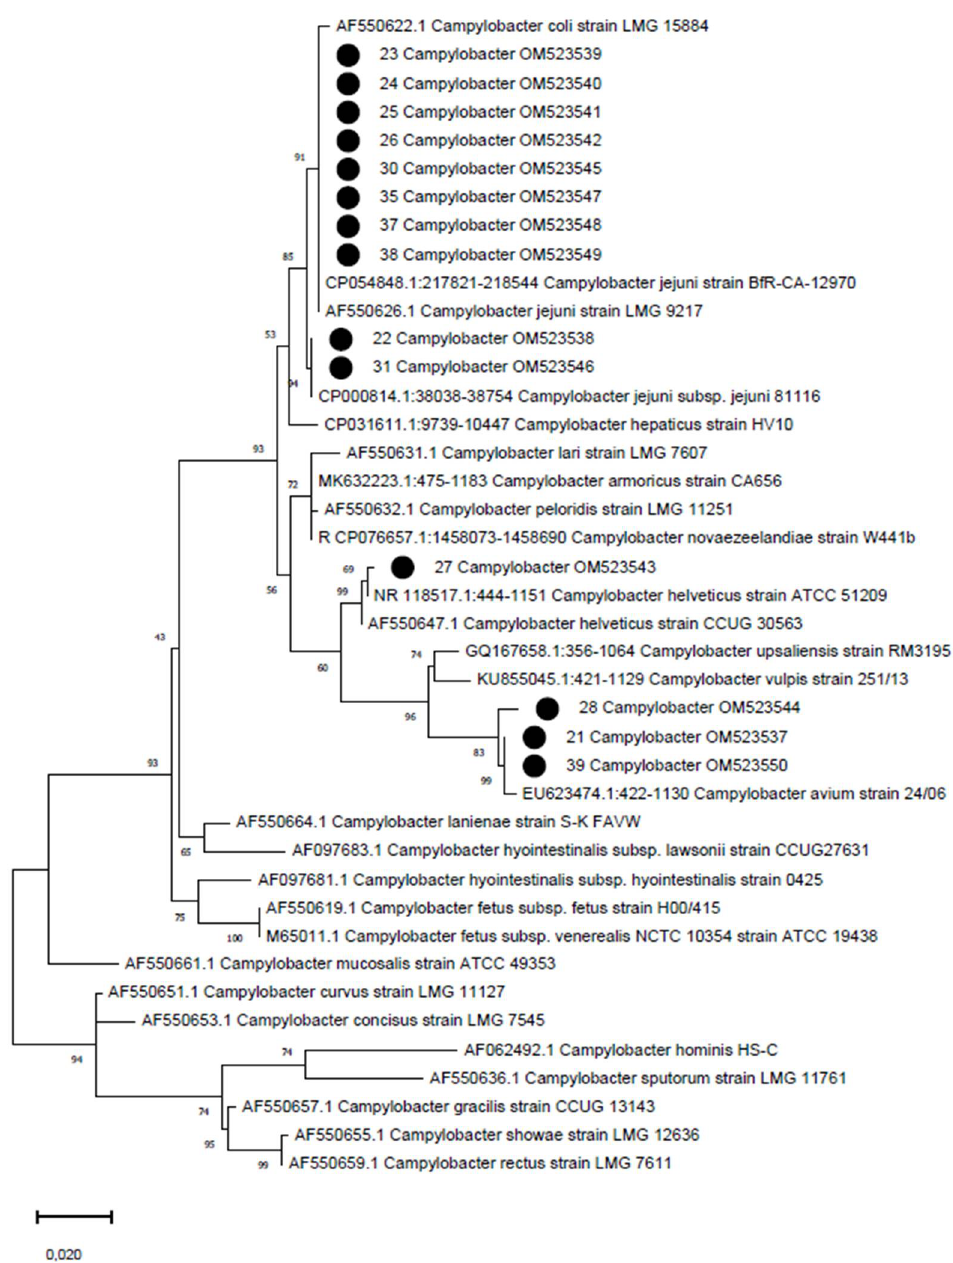
Figure 1. Phylogenetic tree reconstructed on 16S ribosomal RNA gene partial sequences of Campylobacter . The Ethiopian strains are marked with a black circle. The phylogenetic tree was reconstructed using the maximum likelihood method, with the Kimura 2-parameter and general time reversible model with discrete gamma distribution. Branch support is shown next to the branches.